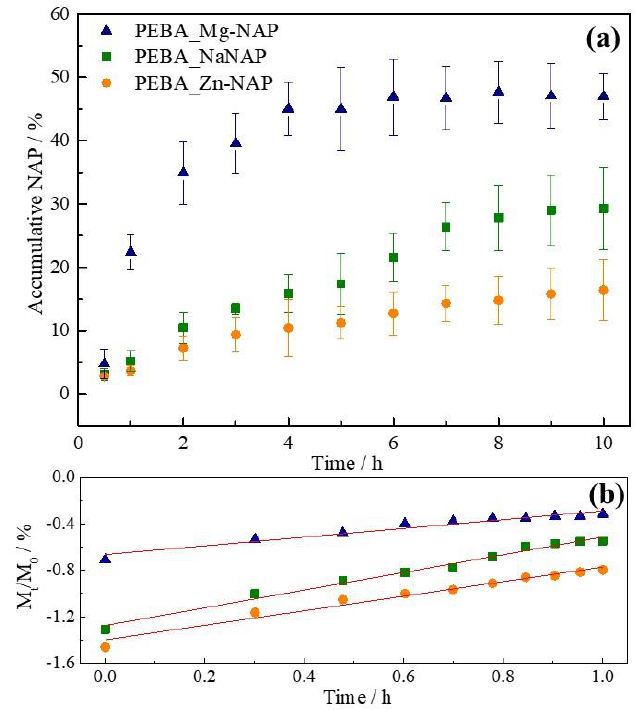
Figure 6. ( a ) Release profile of PEBA_NaNAP, PEBA_Mg-NAP and PEBA_Zn-NAP samples and ( b ) log–log scale for application of Power Law model. Table 4. Release velocity constant (k), exponent of release (n) and coefficient of determination ( R 2 ) obtained from the application of Power Law kinetic release model.